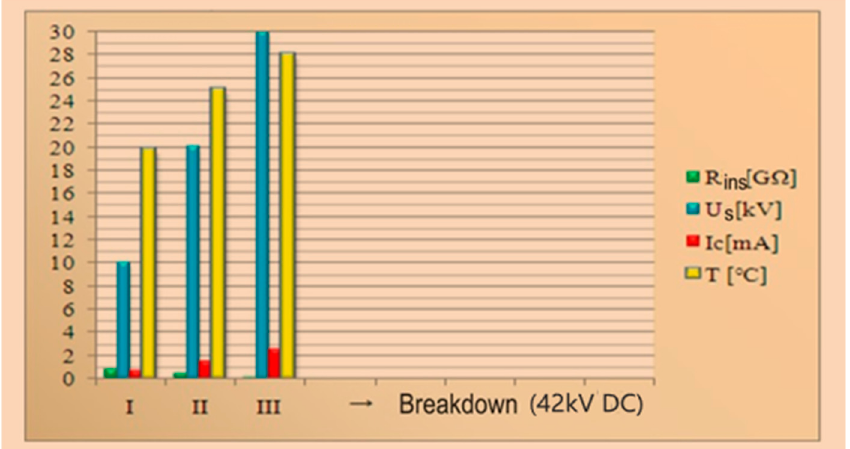
Figure 8. Graphic representation of the dimensions until the moment of penetration of the insula ‐